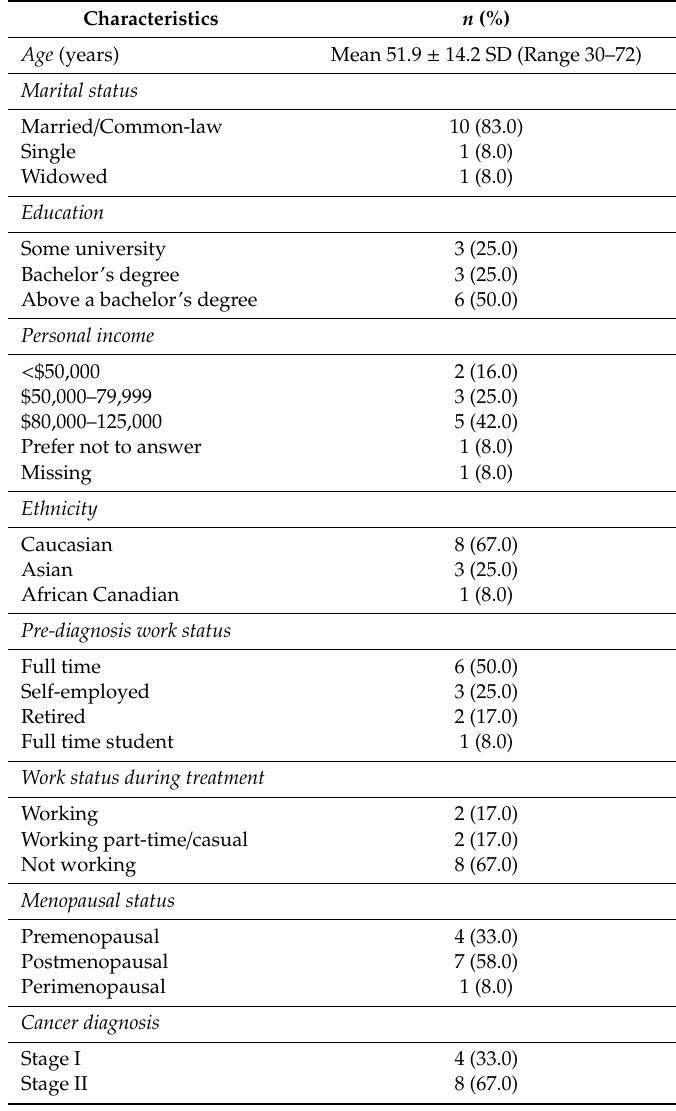
Table 1. Breast cancer survivor demographic and disease characteristics ( n =